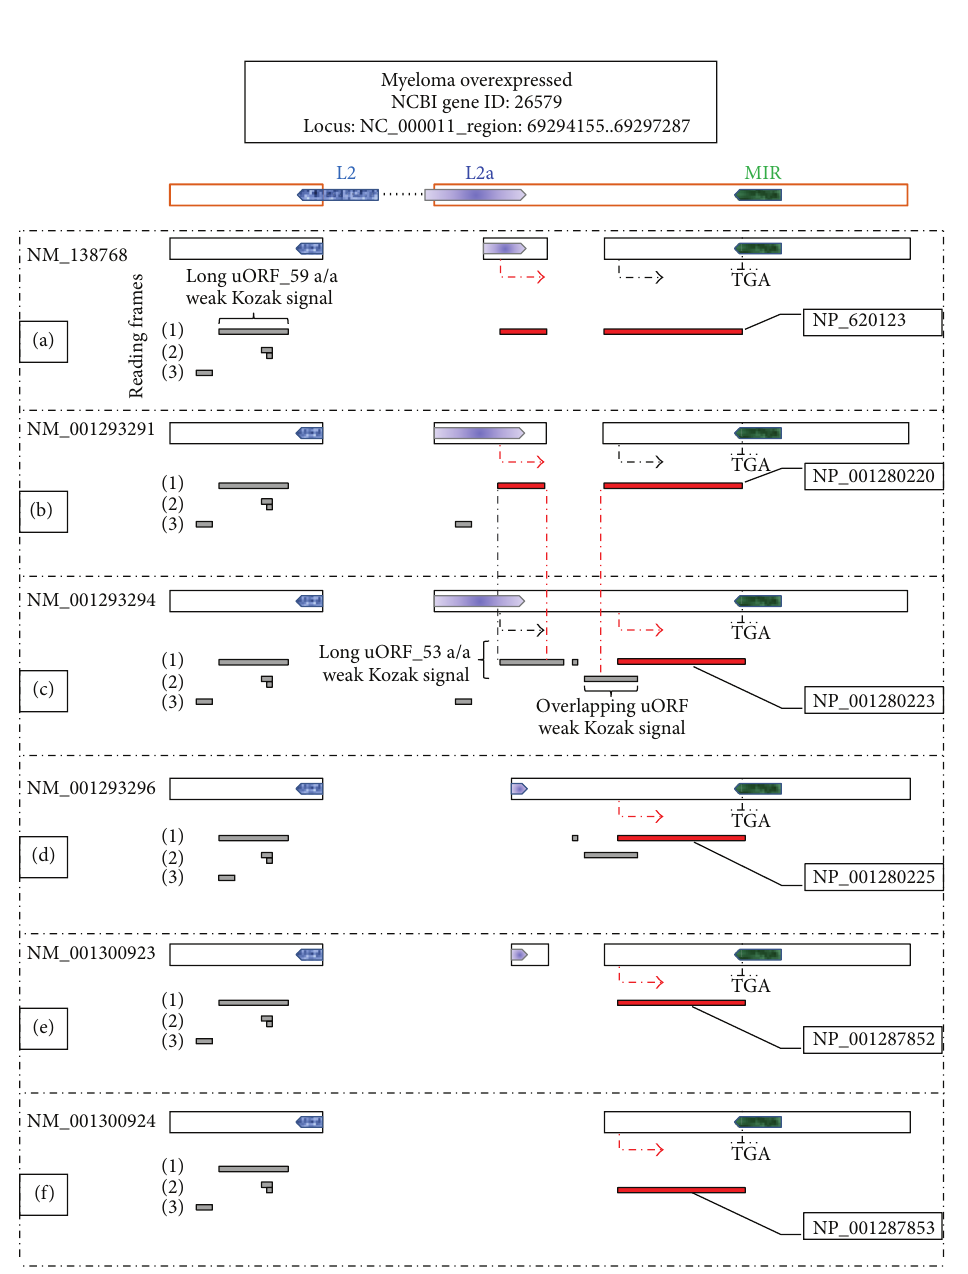
Figure 1: MYEOV alternatively spliced variants. Illustrated on top is the genomic organization of MYEOV locus. Bold, orange line boxes correspond to exonic segments of the genomic sequence. Pentagons overlapping the boxes delineate the location and orientation of the three TEs referred to in the text. (a–f) Six MYEOV alternatively spliced variants encode for either MYEOV-313 or MYEOV-255, according to the NCBI Gene database. Bold, black line boxes for MYEOV exonic content corresponding to each variant. Directional arrows correspond to the functional start signals of MYEOV ; red directional arrows are for the start codons demarcating the respective pORF in each variant. The common stop codon location (TGA) is also indicated. Provided below the exonic content, depicted as dark-grey horizontal bars and juxtaposed to the respective pORFs (red horizontal bars), are the uORFs present in each mRNA sequence; long uORFs are annotated in the context of significantly impairing translational efficiency. Numbers in parentheses correspond to consecutive reading frames, starting from the first, second, and third nucleotide of each variant. Importantly, a prerequisite for MYEOV long-ORF to occur is the region demarcated by red vertical lines to be spliced out of the mRNA